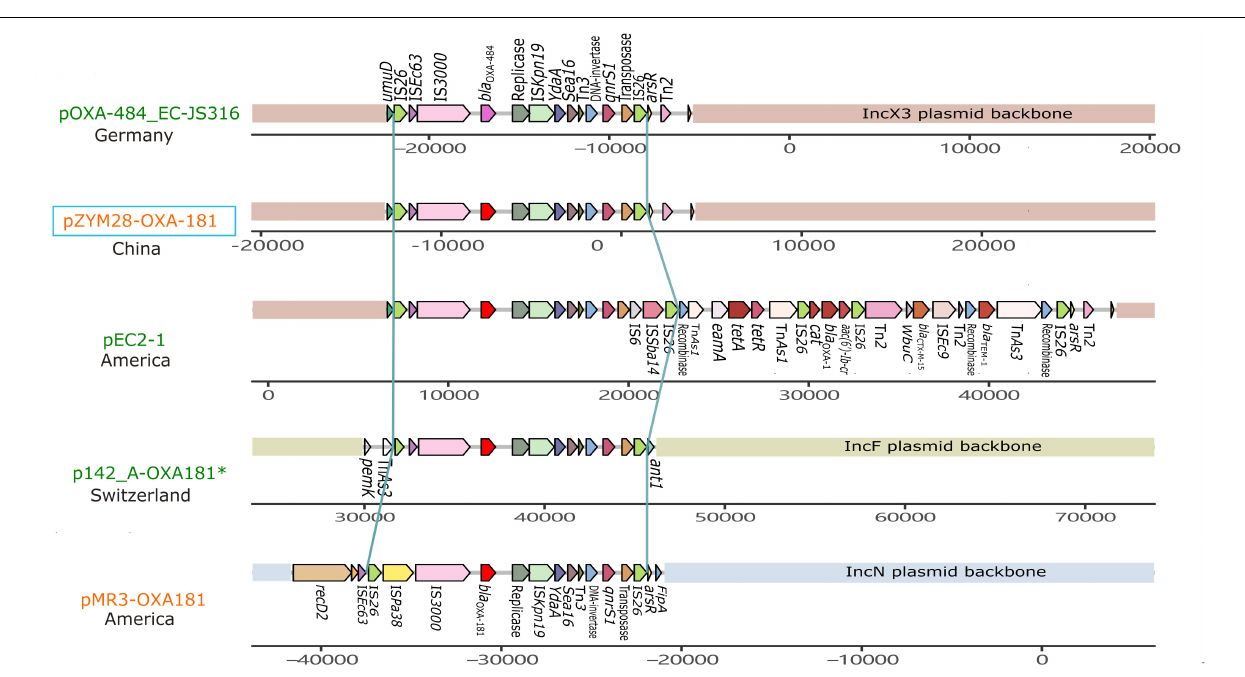
FIGURE 3 | Genetic context comparisons among the transposons carrying bla OXA- 181 and qnrS in different plasmids. Genes and ORFs are shown as arrows without orientations. Accession numbers of these plasmids are CP058621.1, MW080368.1, CP041956.1, CP048338.1, and KM660724.1 from top to bottom. All the plasmid are isolated from Homo sapiens except p142_A-OXA-181 (labeled with a green *). Plasmids identified from Morganella morganii are shown in orange and from Escherichia coli are shown in red. pZYM28-OXA-181 in this study is noted with a blue hollow rectangle. The picture was drawn with gggenes aligned with bla OXA- 181